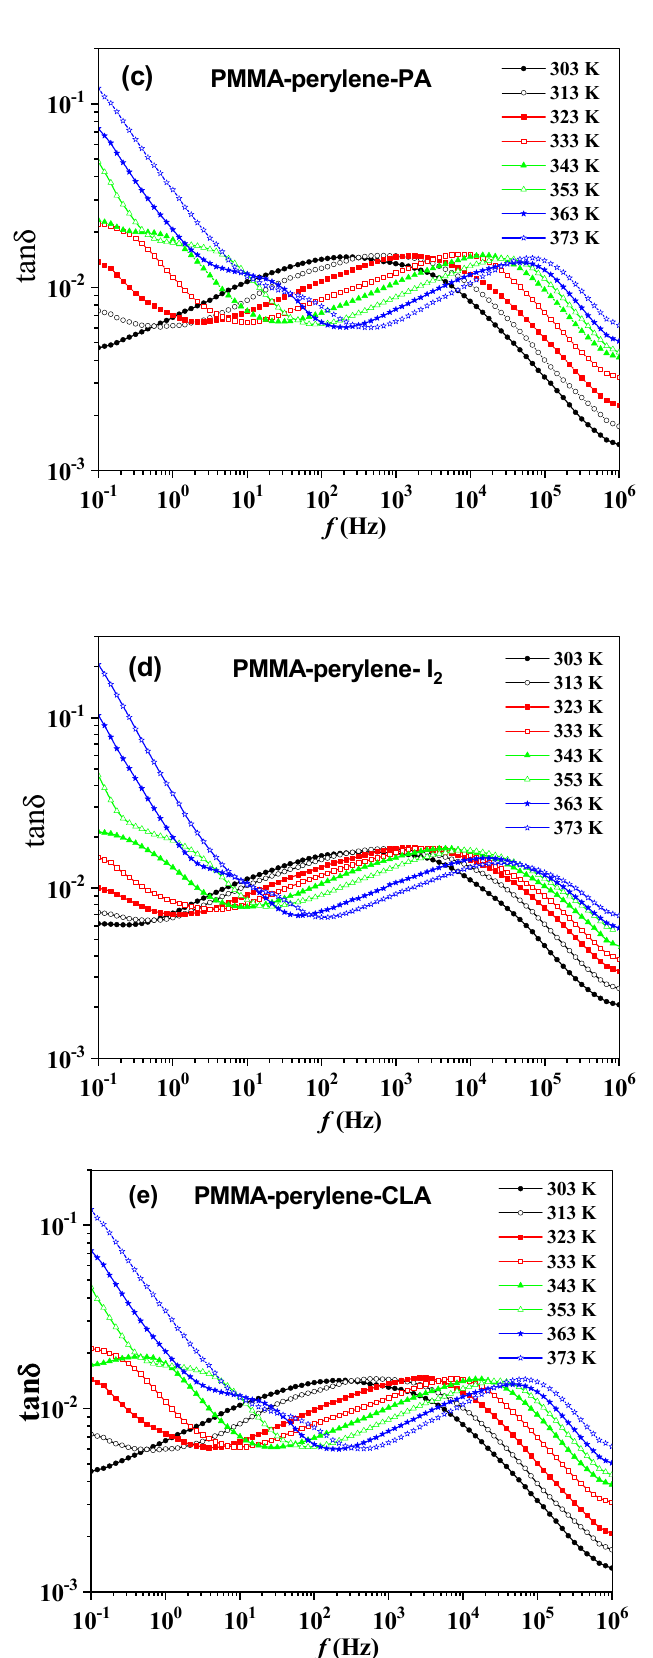
Figure 6. ( a – e ): The frequency dependence of the tan δ of the synthesized polymeric sheets. Another representation of the complex relative permittivity ( 𝜀 ∗ ) is the complex elec- tric modulus ( 𝑀 ∗ ). The 𝑀 ∗ formalism gives a clearer characterization of the dipolar relax- ation mechanisms of the synthesized polymeric sheets. The 𝑀 ∗ formalism is described by the following relation [25]. 𝑀 ∗ = 1 𝜀 ∗ = = 𝑀 (cid:2869) + 𝑖𝑀 (cid:2870) = 𝜀 (cid:2869) 𝜀 (cid:2869) (cid:2870) + 𝜀 (cid:2870) (cid:2870) + 𝑖